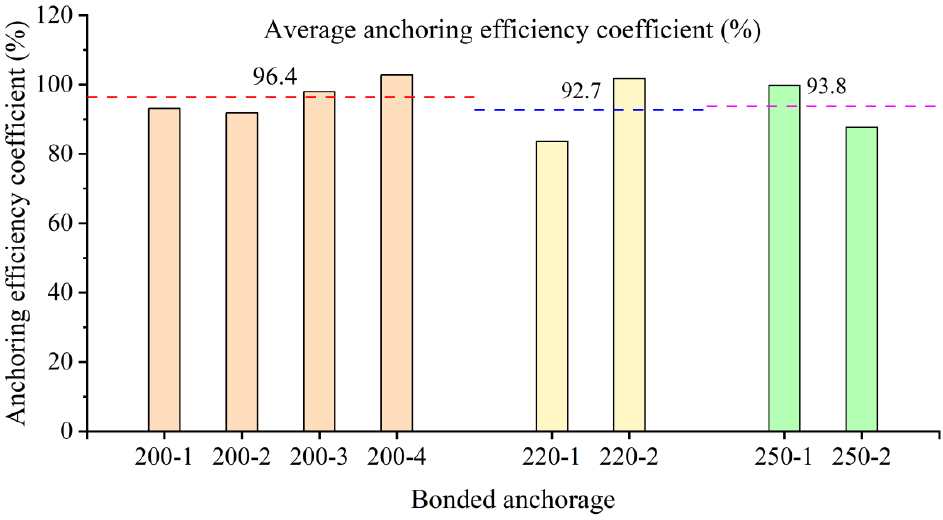
Figure 17. Comparison chart of anchoring efficiency coefficients of three types of anchors.